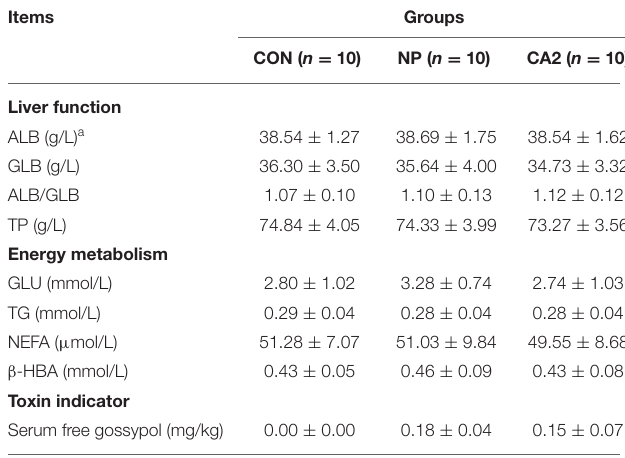
TABLE 4 | The effect of different alkali mixtures on the coefficient of intestinal digestibility of WCS in vitro . Alkali mixtures